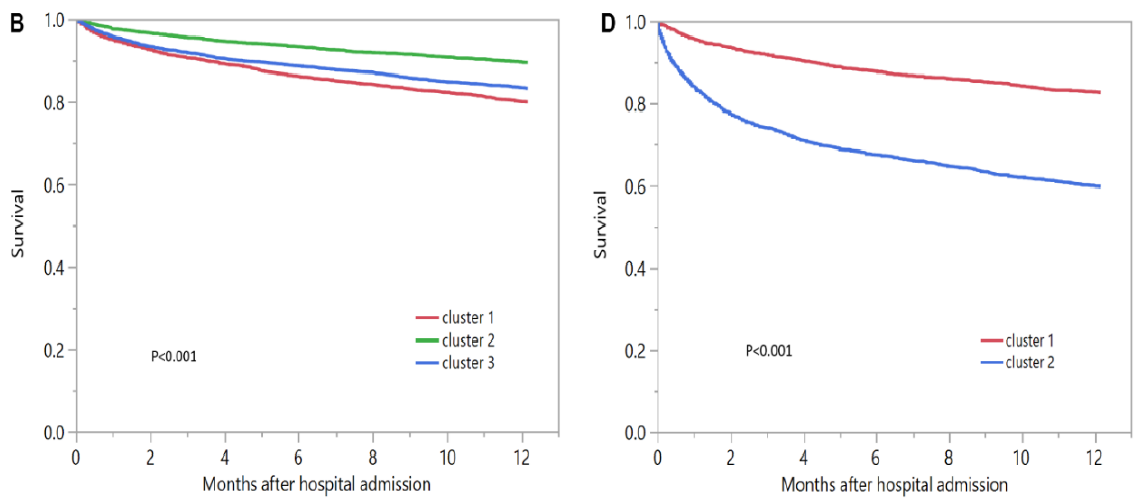
Figure 5. ( A ) Hospital mortality and ( B ) One-year mortality among different clusters of admission hypomagnesemia; ( C ) Hospital mortality and ( D ) One-year mortality among different clusters of admission hypermagnesemia. Compared to cluster 2, cluster 1 and cluster 3 also had higher risk of one-year mortality with HR of 2.04 (95% CI 1.79–2.32) and 1.68 (95% CI 1.49–1.90) respectively (Table 2). Table 2. Mortality outcomes according to clusters.